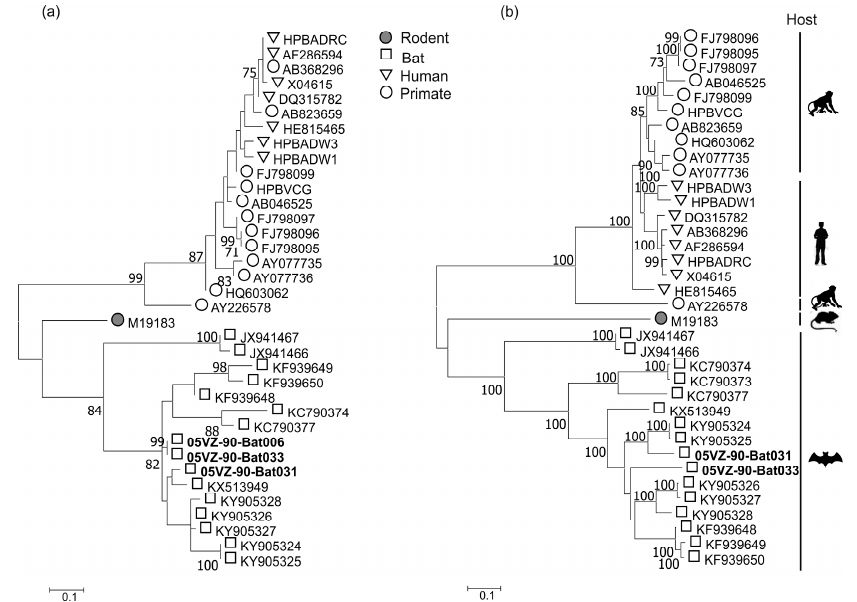
Figure 4. Maximum likelihood trees of ( a ) the screening fragment and ( b ) the polymerase of hepadnaviruses using the best-fitting models of JTT+G and JTT+G+I+F, respectively. Labels for sequences obtained in this study are highlighted in bold. Bootstrap support values of ≥ 70% are shown. The trees were drawn to scale; bar, estimated number of substitutions per